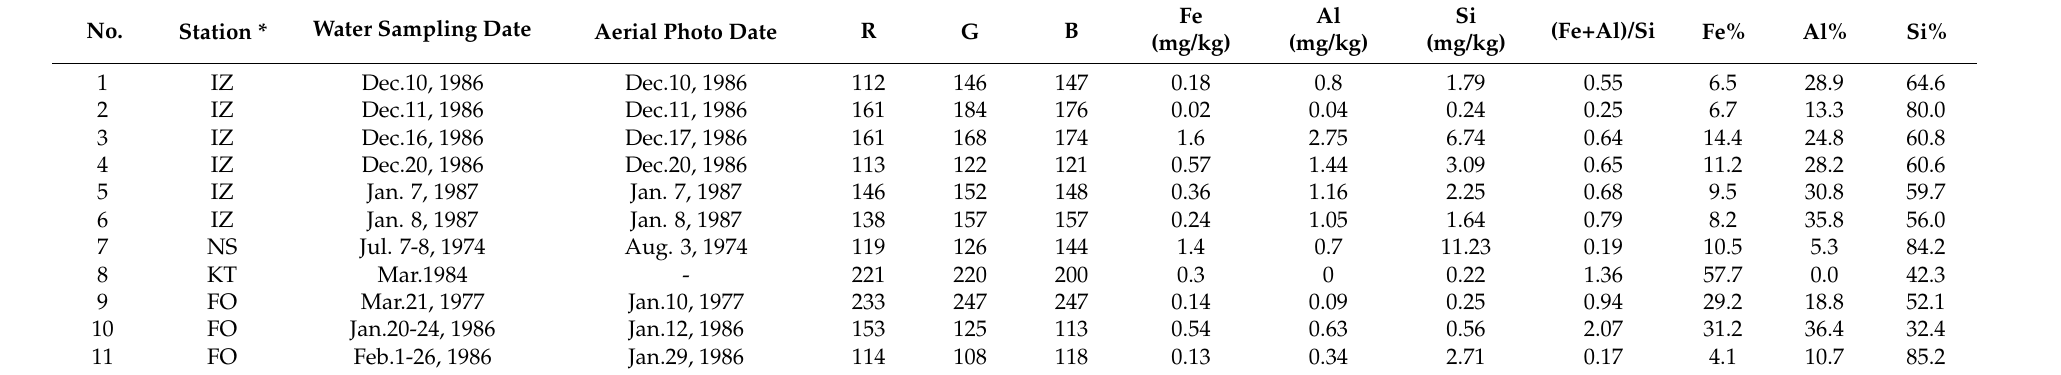
Table 1. Modified data set of discolored seawater (RGB) from aerial photographs and measured chemical composition (Fe, Al, and Si) for discolored seawater around Japanese submarine volcanoes summarized by Watanabe